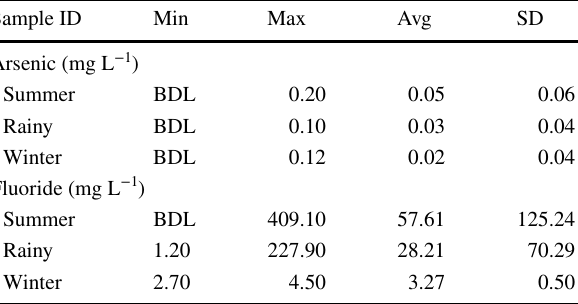
Table 3 Seasonal concentration of As 3/5+ and F − in water